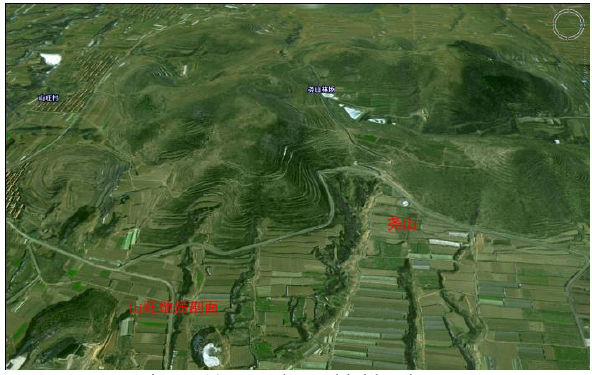
Figure 12. Yaoshan shield volcano